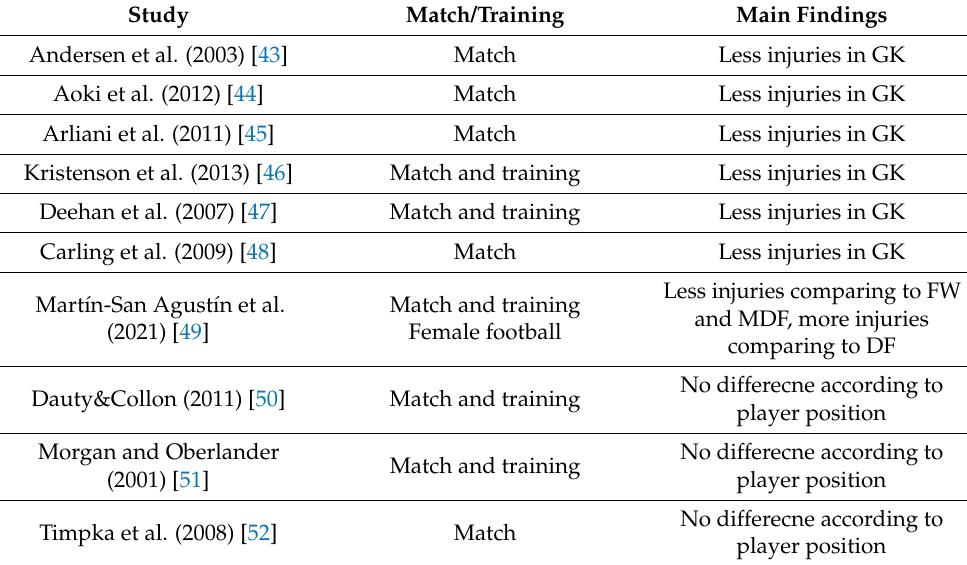
Table 1. Injuries in GKs and field